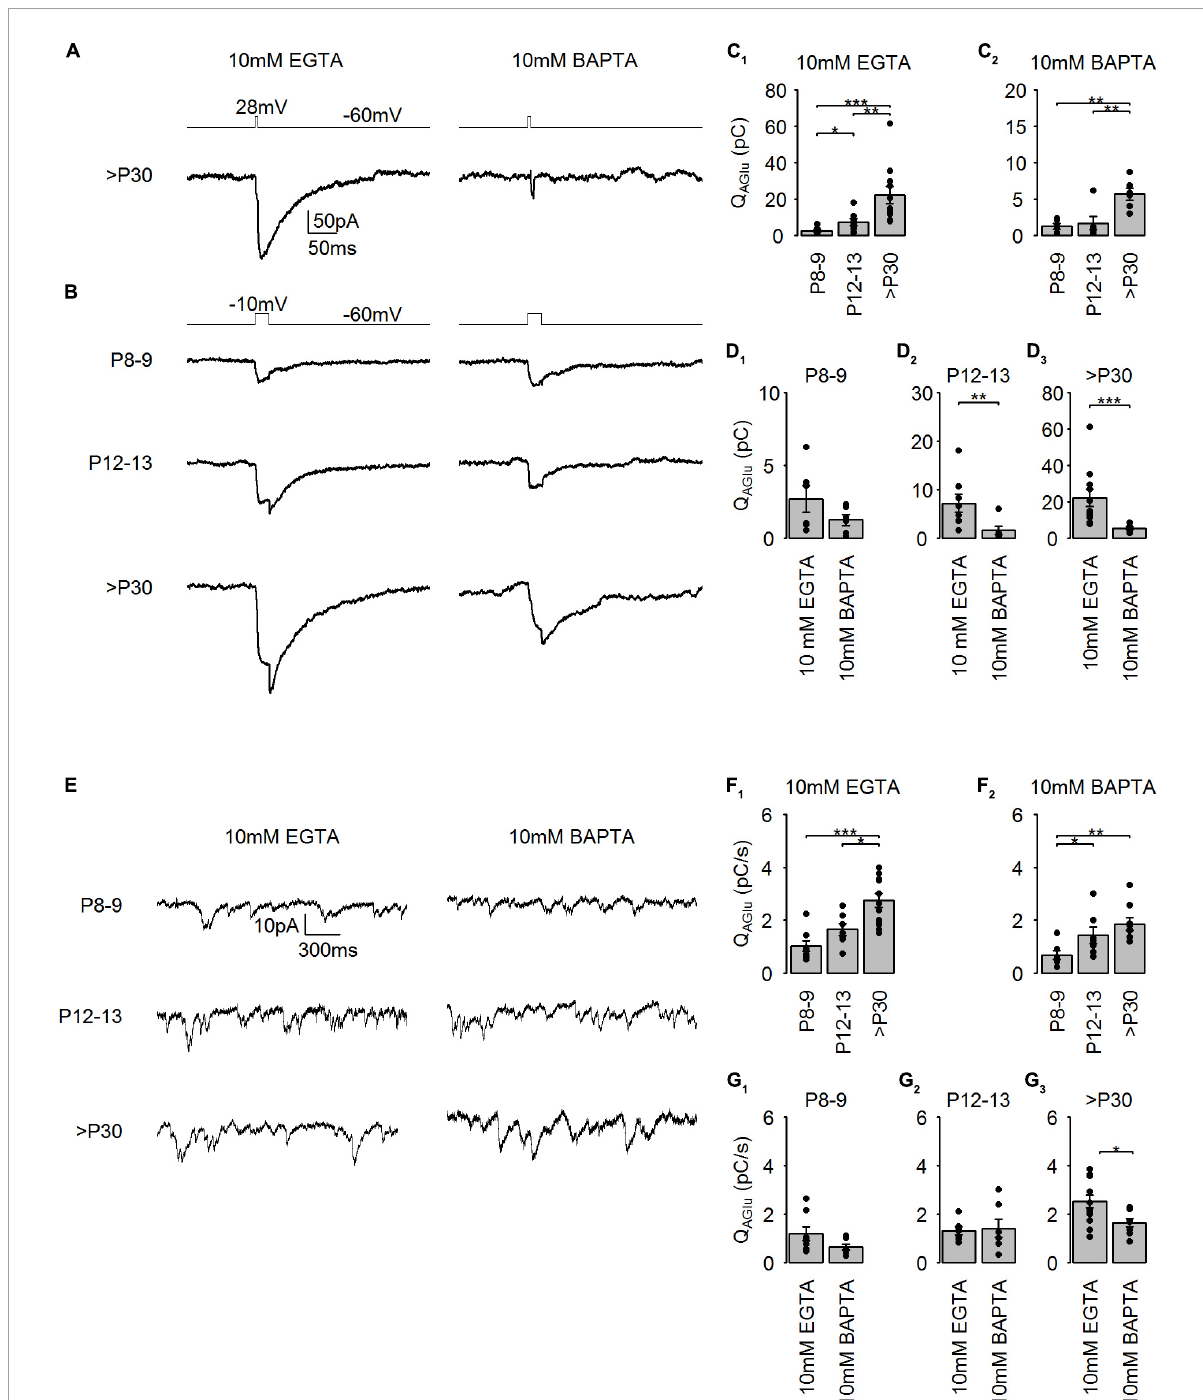
FIGURE6 Developmental changes in Ca 2 + channel domain organization at mouse cone photoreceptors. (A) Representative traces of I AGlu events evoked by step depolarizations (–60 to 28 mV for 5 ms) in the presence of either 10 mM EGTA or 10 mM BAPTA at > P30. (B) Representative traces of I AGlu events evoked by step depolarizations (–60 to –10 mV for 25 ms) in the presence of either 10 mM EGTA or 10 mM BAPTA at the different developmental stages. (C 1 ) Charge transfer of I AGlu evoked by step depolarizations (–60 to –10 mV for 25 ms) in the presence of 10 mM EGTA ( p < 0.001, n = 6–11 cells, Kruskal-Wallis test). Post hoc Mann–Whitney U -test (P8–9 vs. P12–13: p = 0.043, P8–9 vs. > P30: p < 0.001, P12–13 vs. > P30: p = 0.004). (C 2 ) Charge transfer of I AGlu evoked by step depolarizations (–60 to –10 mV for 25 ms) in the presence of 10 mM BAPTA ( p = 0.001, n = 6 cells, one-way ANOVA). Post hoc Tukey tests (P8–9 vs. P12–13: p = 0.726, P8–9 vs. > P30: p = 0.002, P12–13 vs. > P30: